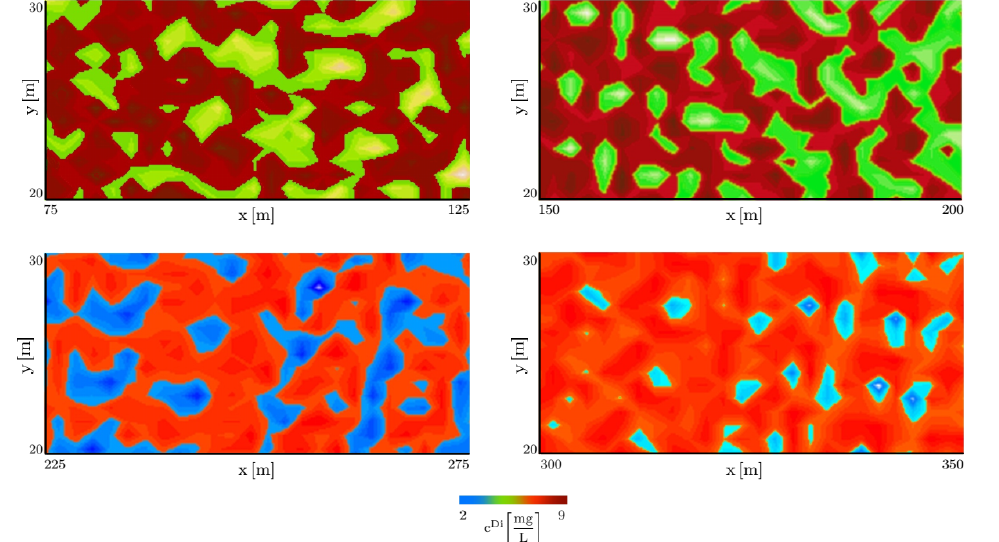
Figure 9. The distribution of the contaminant concentration at different region of the aquifer at t = 128